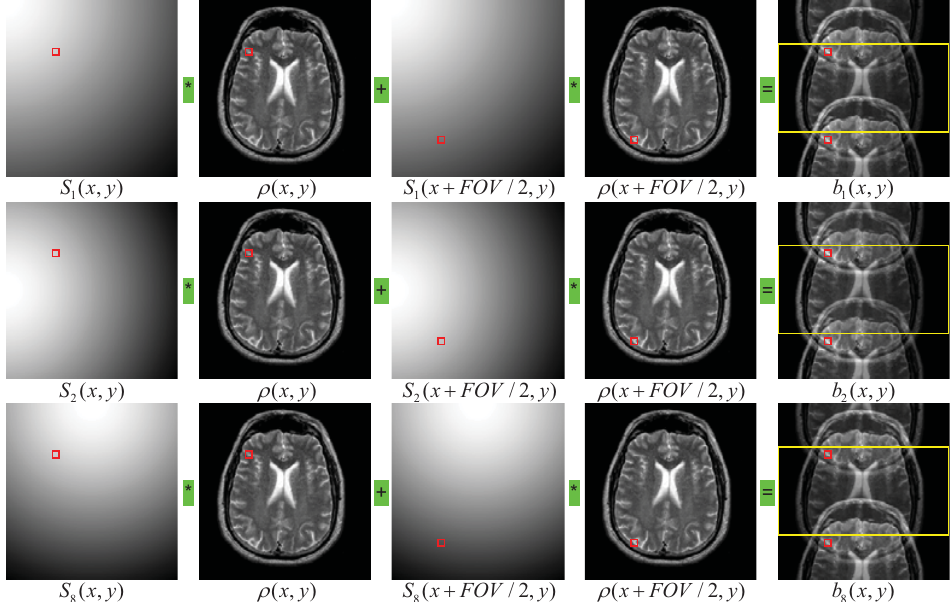
Figure 1. A pictorial illustration of the SENSE principles. The k-space is scanned every other row. The rows are for the first, the second and the eighth channels, respectively. Column 1 & 3 are the sensitivity maps, column 2 & 4 are the brain or the images to be reconstructed, and final column is the aliased brain images acquired by the corresponding channels. The red square marker denotes the pixel at location ( x , y ).